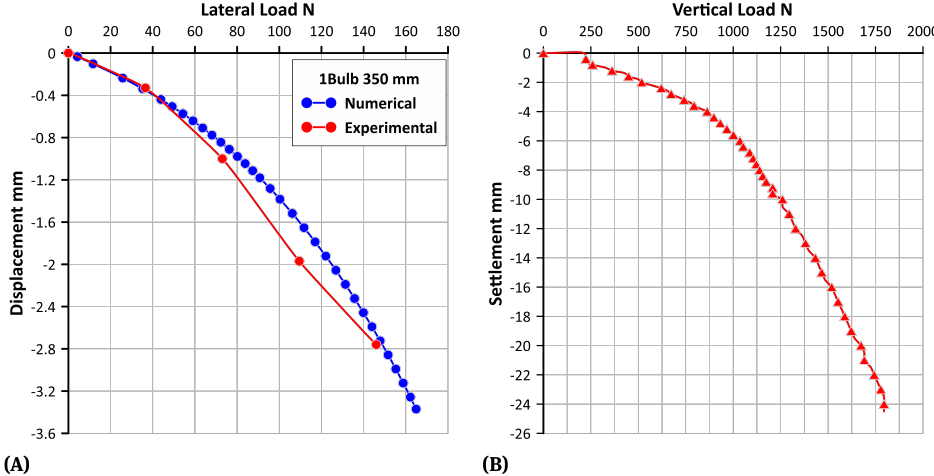
Figure 4: (A) Comparison of lateral bearing capacity for single bulb pile between numerical and experimental (B) Load settlement test